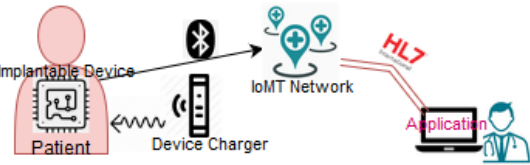
Figure 4. Operation of an implantable device.